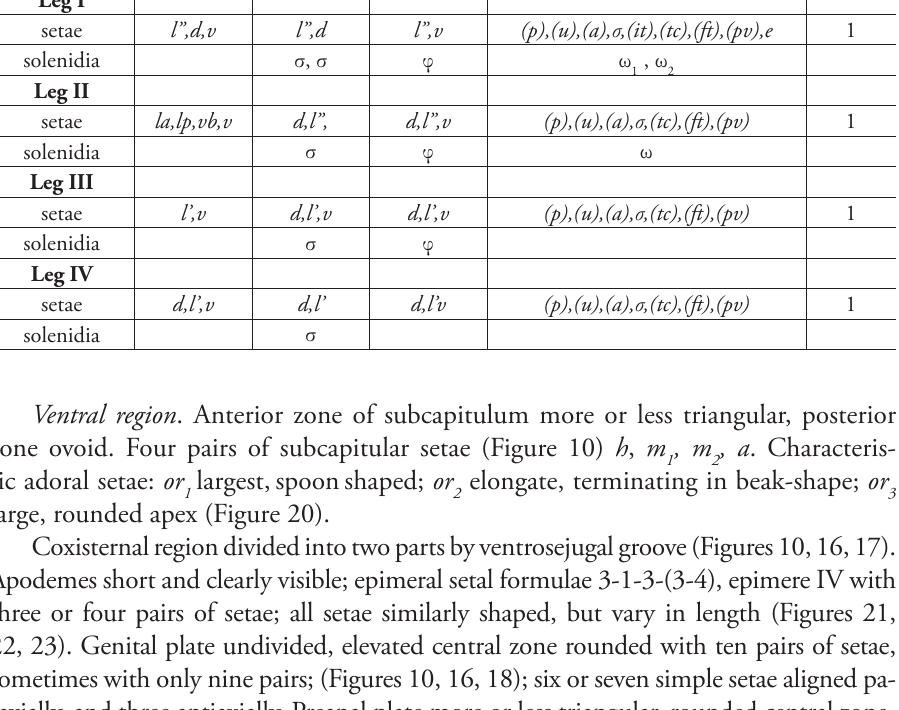
Table 1. Mixacarus turrialbai sp. n.: setae and solenidia. Femur Genu Tibia Tar s u s Cla